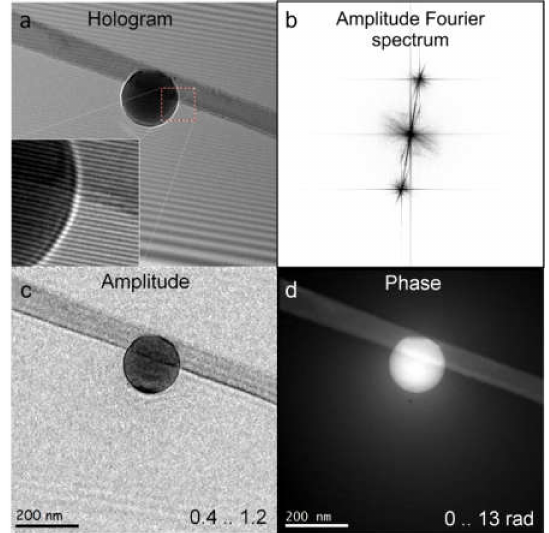
Figure 13. Electron o ff -axis hologram of a latex sphere and its reconstruction. ( a ) O ff -axis hologram of a latex sphere recorded at 200 keV, with Fresnel fringes from the biprism filament edge readily visible. ( b ) Amplitude of the Fourier spectrum of the hologram shown in ( a ). ( c ) Reconstructed amplitude. ( d ) Unwrapped reconstructed phase, with phase values between 0 and 13 rad. Reprinted from [53], with permission from